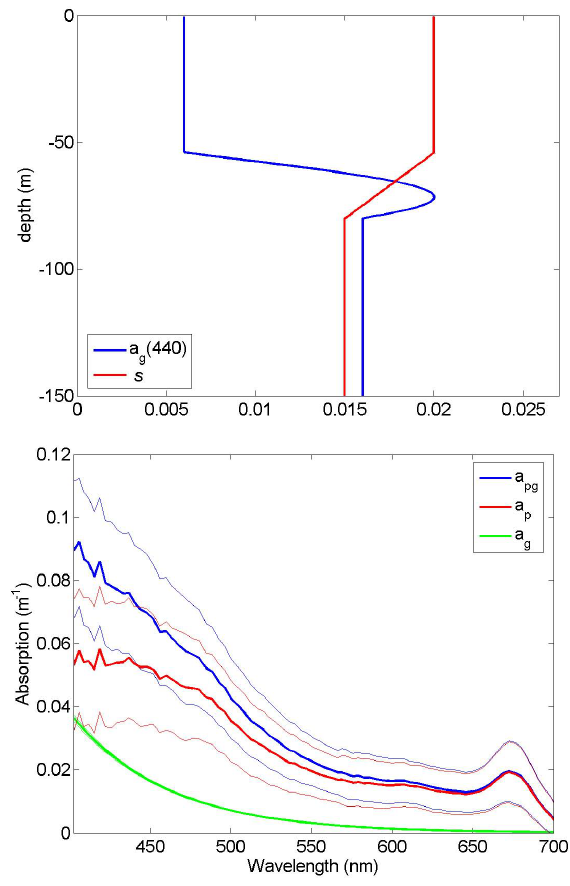
Fig. 4. (top) Vertical profiles of CDOM absorption at 440nm [ a g ( 440 ) ] and the exponential coefficient s , used to reconstruct the vertical distribution of a g (λ) using Eq. 2; (bottom) Average spectra of measured total absorption [ a pg ], reconstructed CDOM absorp- tion [ a g ], and derived particle absorption [ a p ] within the DCML (thinner lines indicate the one standard deviation